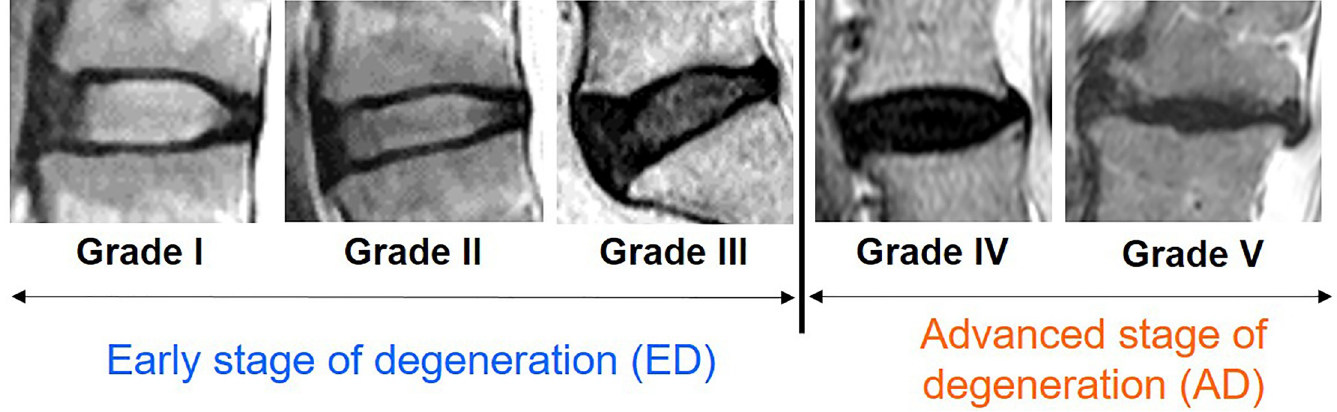
Fig 1. Magnetic resonance imaging (MRI) of human intervertebral disc classified according to the Pfirrmann grading system[22]. Grades I to III were classified as early stage degeneration (ED). Grade IV and V were classified as advanced stage degeneration (AD).